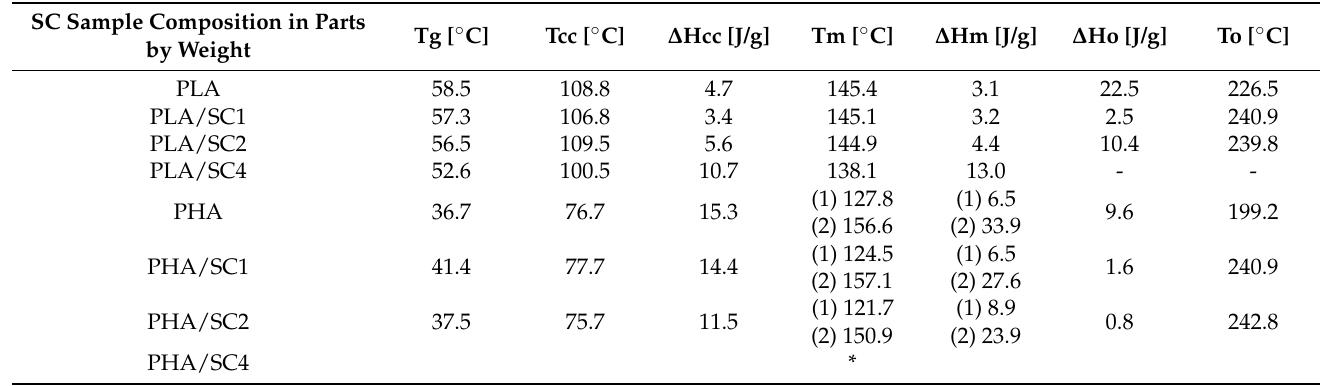
Table 1. The DSC analysis of the PLA and PHA samples with succinic acid (SC). SC Sample Composition in Parts